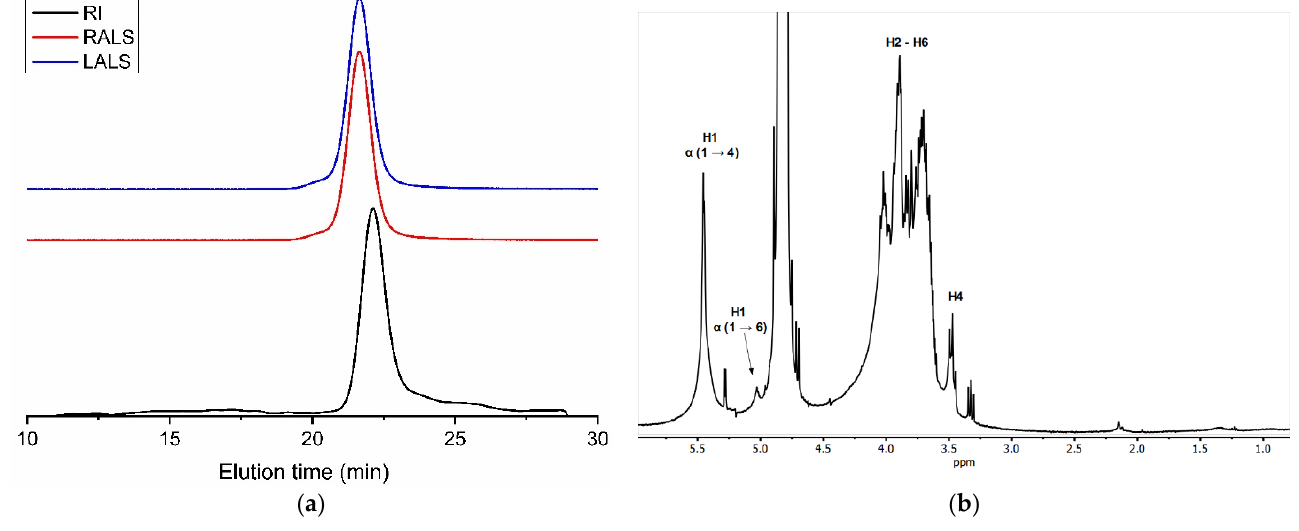
Figure 8. GPC eluogram ( a ) and 1 H NMR spectrum ( b ) of glycogen extracted from the internal organs of Styela clava . Black trace: refractive index detector (RI); red trace: right ‐ angle light scattering detector (RALS); and blue trace: low ‐ angle light scattering detector (LALS).